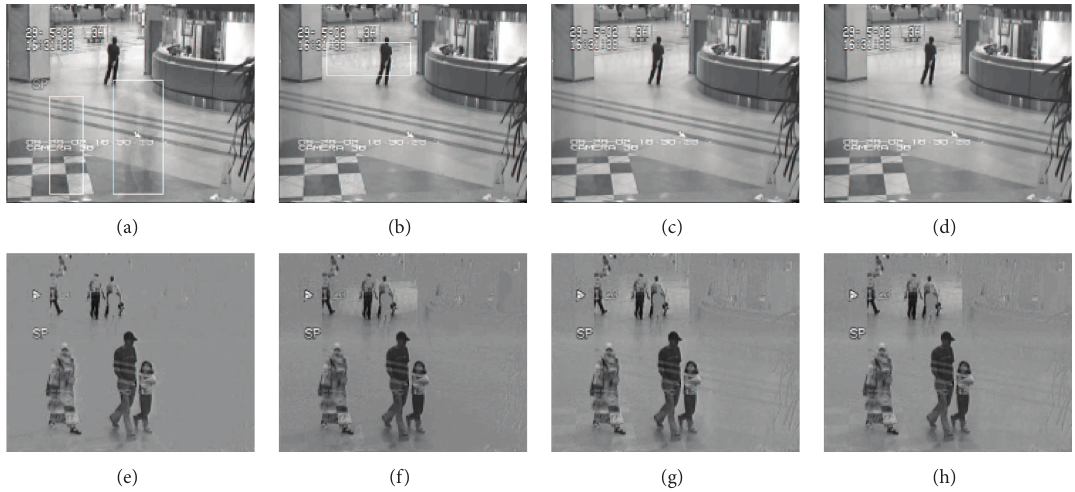
Figure 3: Airport: (a)–(d) background and (e)–(h) foreground from IALM, GoDec, NSMP, and WNSMP.